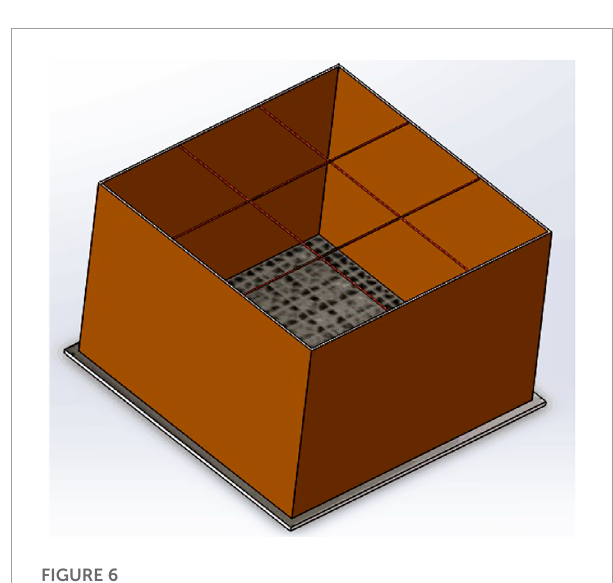
FIGURE 6 Tile flow regulation